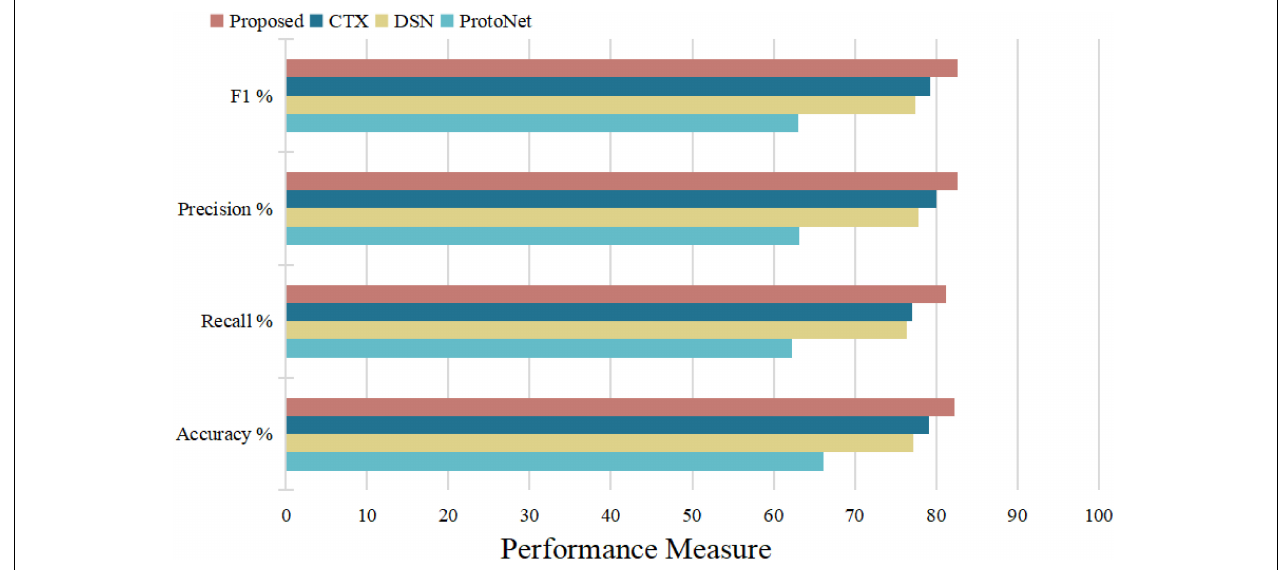
FIGURE 14 | Performance comparison with various